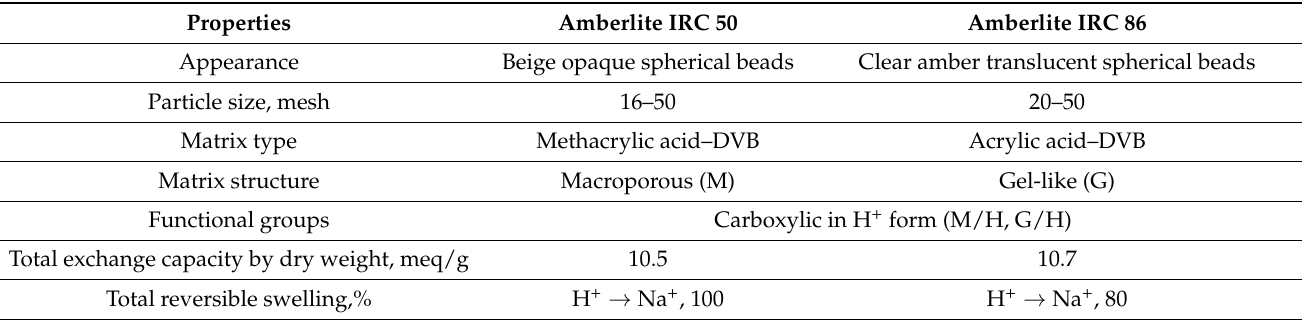
Table 1. Characterization of polymeric